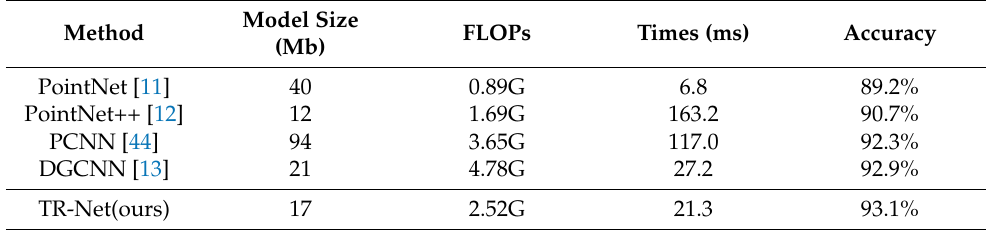
Table 6. The comparison with different models on complexity, forward time, and